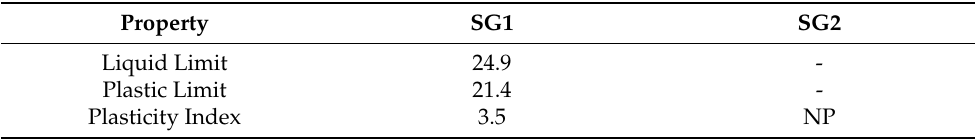
Figure 4. Subgrade soil gradations.